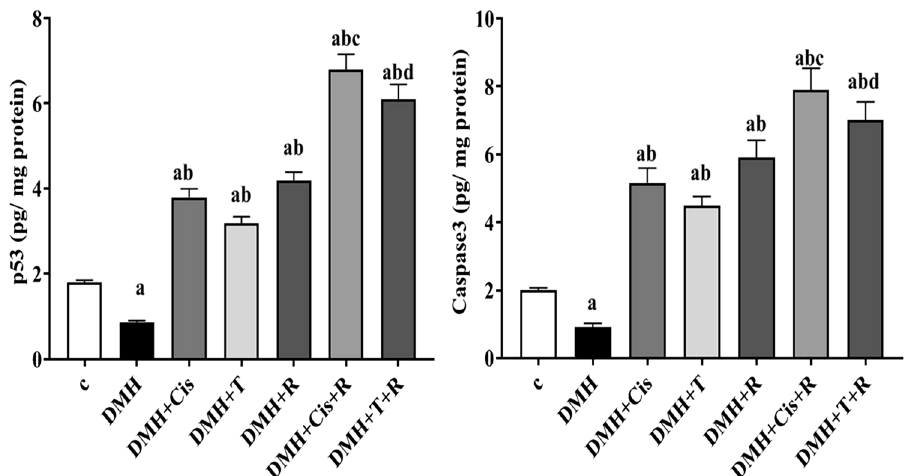
Fig. 8 Effect of thiophene derivative and γ-irradiation on the cleaved caspase3 and phosphorylated p53 levels.